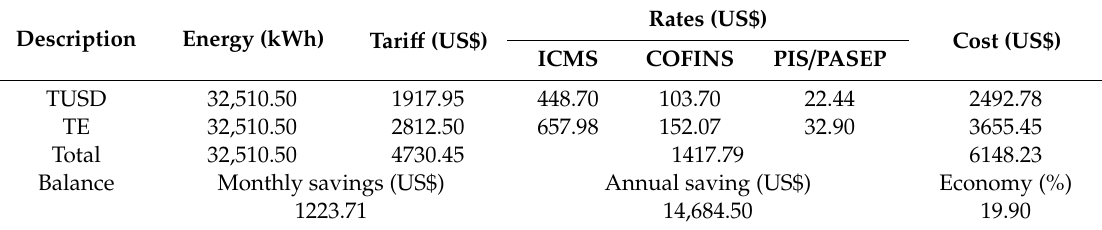
Table 3. Energy costs according to the conventional tari ff and comparison with the White Tari ff .